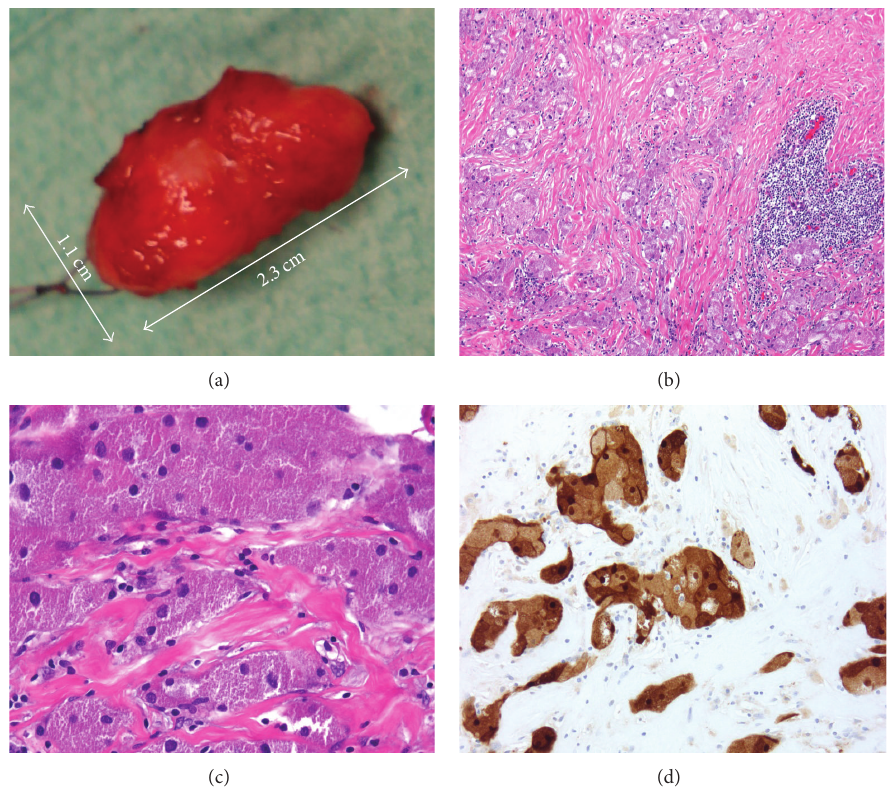
Figure 2: Histological analysis of the excised mass. Macroscopic examination, showing size and morphology of the mass (a). Histological analysis showed typical GCT histology with granular cytoplasm. Cells were imbedded in a connective tissue bed (b) with batches of high density of nuclei. Cells were large in size with small nuclei and granular cytoplasm (c). Immunohistochemical staining against S-100 protein was positive in the cytoplasm